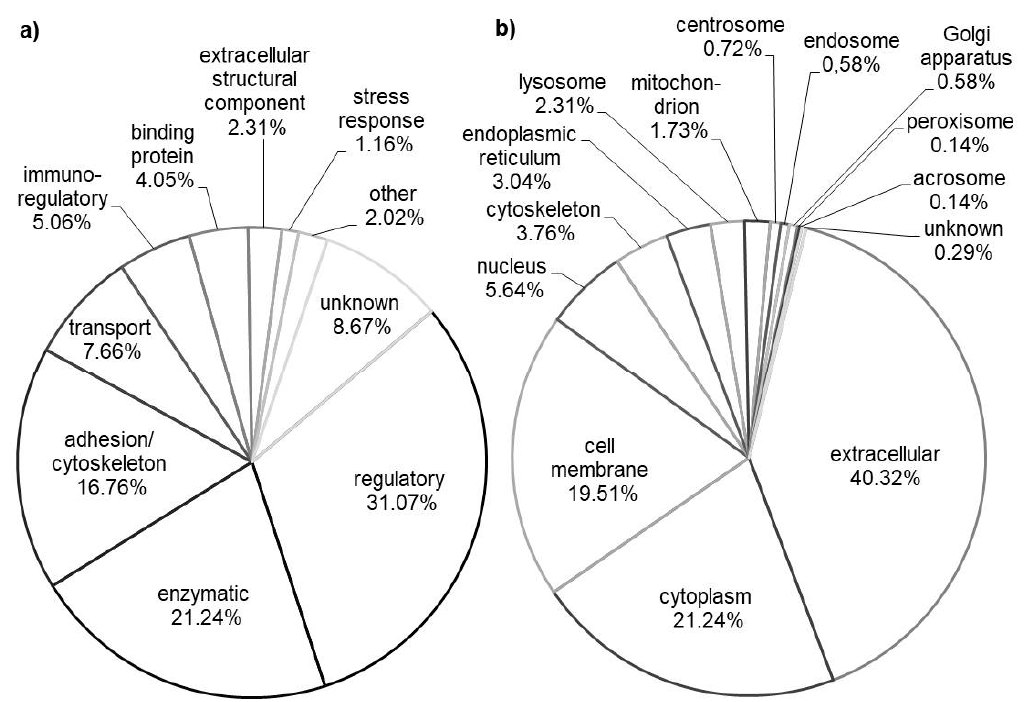
Figure 3. Biological function ( a ) and subcellular localization ( b ) of calf urinary proteome components. The largest group of proteins was involved in various regulatory processes (31.07%), Figure 3a. Enzymes (21%) and proteins involved in cell adhesion and organization of the cytoskeleton (16%) were the next two largest